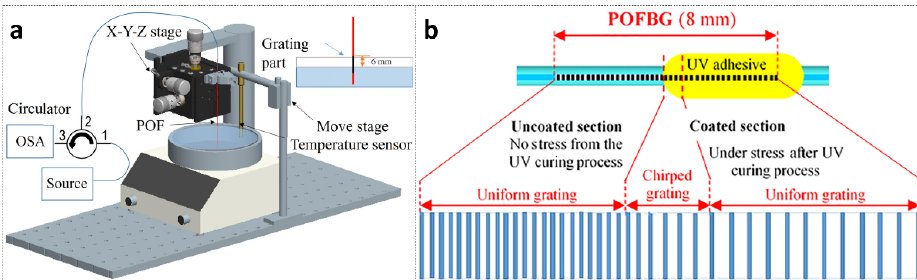
Figure 18. ( a ) The experimental set ‐ up for gradient thermal annealing. Reprinted from [94]. ( b ) Sketch of the produced CFBG structure with period variation along the grating length after UV curing. Reprinted with permission from [95].